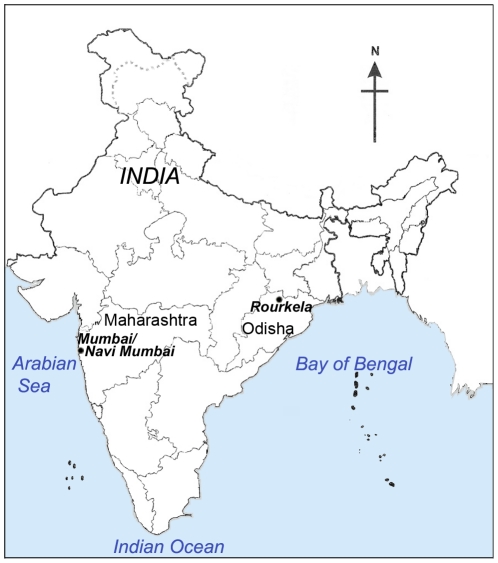
Geographical location of data collection sites in India.